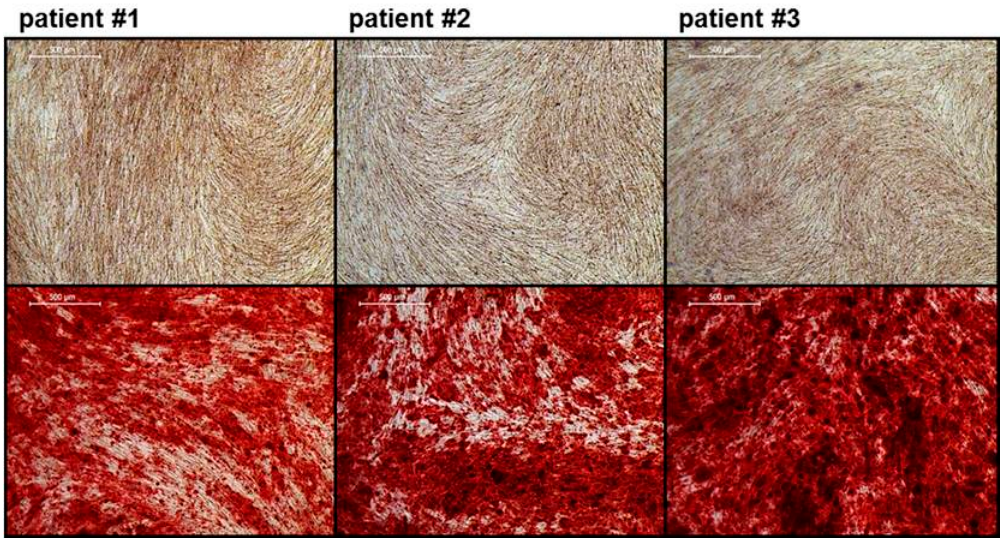
Figure 7. Osteogenic differentiation potential of iMSCs. iMSCs incubated without osteogenic stimuli (control, upper panel) and osteogenic medium (lower panel) for 15–20 days, stained with alizarin red (scale bars represent 500 µm).